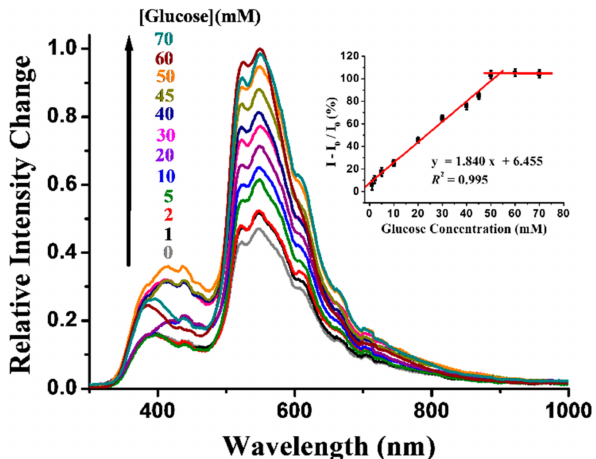
Figure 3. Emission spectra of the gel-encapsulated B5 sensing system under different concentrations of glucose. Inset: Percentage of emission change as a function of glucose concentration calibration curve obtained for biosensor (N = 3).